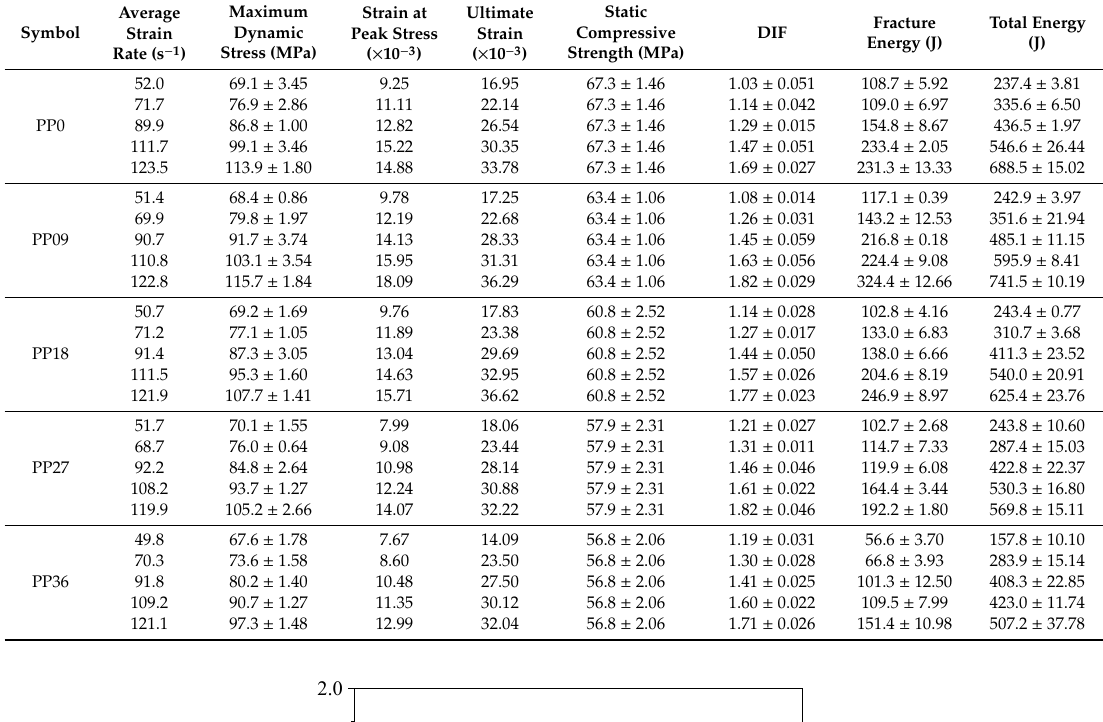
Table 7. Summary of dynamic and static properties of PP fibre reinforced concrete.